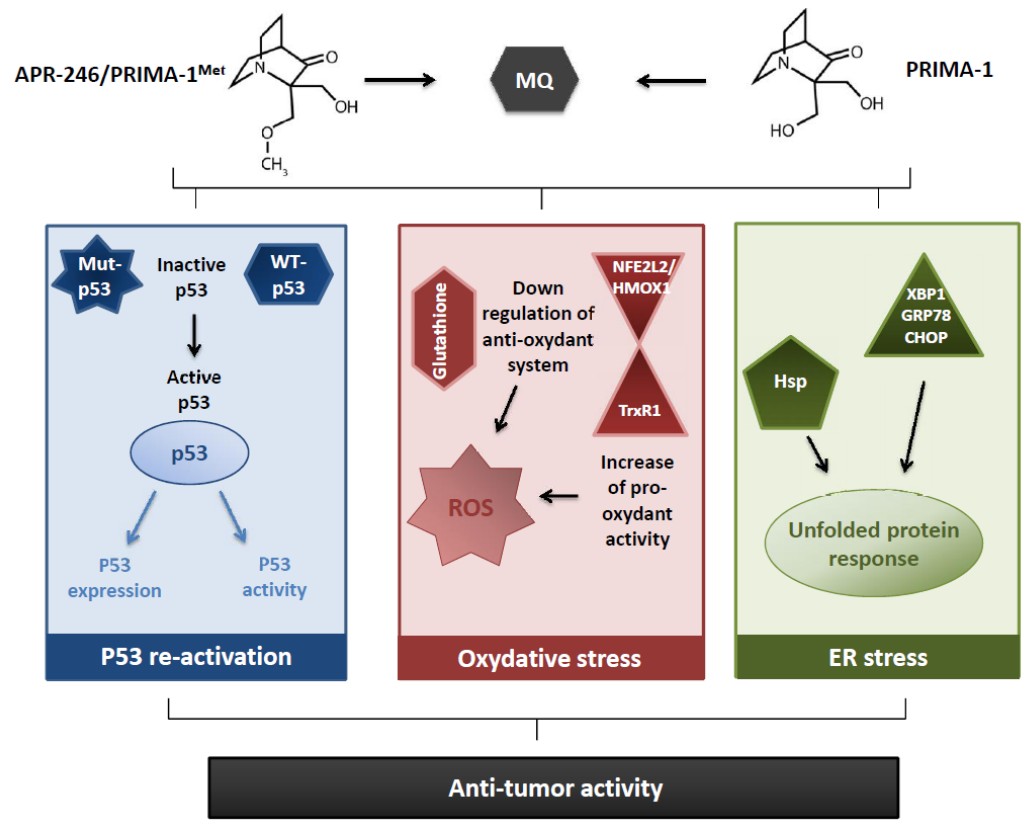
Figure 1. Main reported mechanisms of action of PRIMA-1and APR-246, leading to an anti-tumor activity.